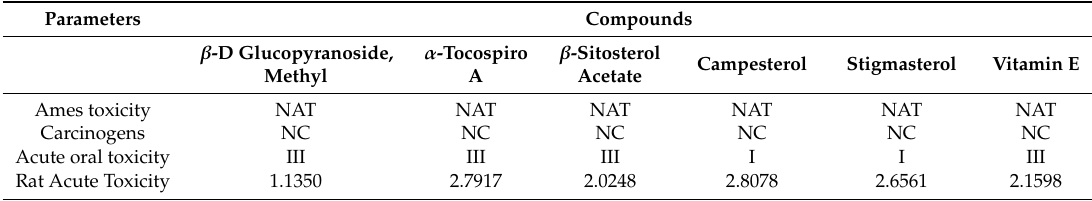
Table 8. Toxicological properties of the selected compounds in MEHC.